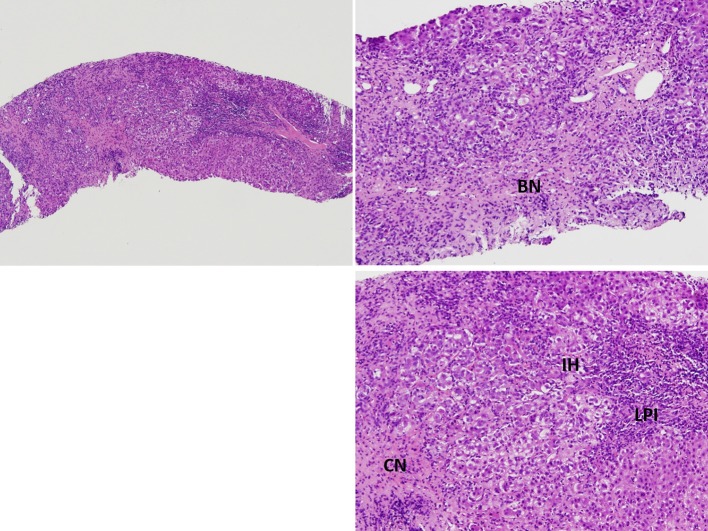
Pathological findings of the liver biopsy showed marked lymphoplasmocytic infiltration (LPI), bridging necrosis (BN) and confluent necrosis (CN), and prominent interface activity (IH), findings compatible with autoimmune hepatitis.